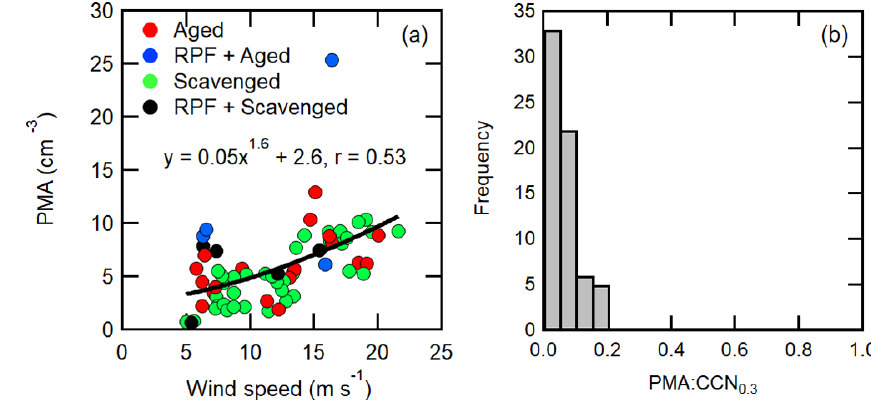
Figure 7. (a) Correlation of estimated PMA concentration and wind speed and (b) the fraction of PMA accounting for CCN 0 . 3 for MBL legs. Exclusion of the outlier in (a) increases the Pearson coefficient to